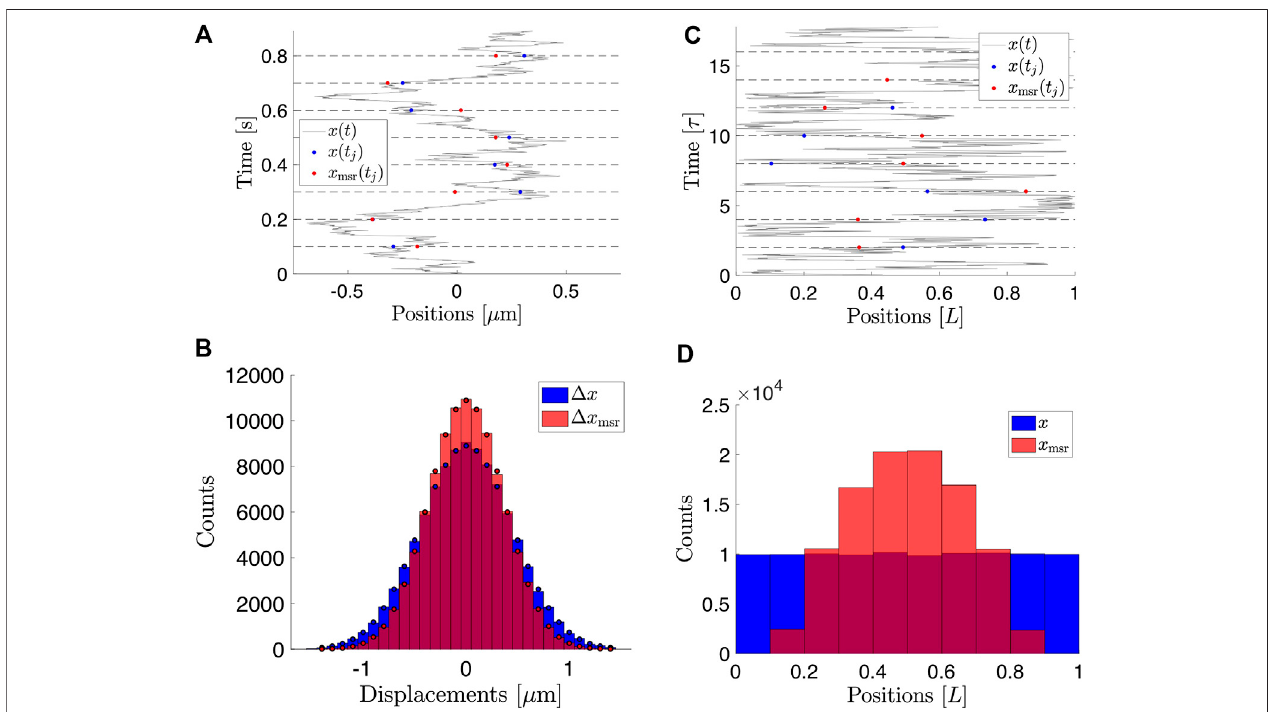
FIGURE 1 | Consequences of finite exposure time for the measured positions of a Brownian particle. (A) Simulated positions of a free Brownian particle with D (cid:2) 1 ( μ m ) 2 / s, Δ t (cid:2) Δ t open (cid:2) 0 . 1s.Inatime-lapse movieofit,inthe(arti fi cial)case ofinstantaneousrecording ofpositions,theparticle ’ spositions x j areitstrue positions measured at the end of each time interval, i.e., at times t j (cid:2) j Δ t (blue dots). In the (realistic) case of fi nite exposure time, the measured positions x msr ( t j ) are the time- averaged positions visited by the particle during the exposure time, as de fi ned in Eq. 1 (red dots). (B) Histograms of the displacements of the true, Δ x j (cid:2) x j − x j − 1 , and the measured, Δ x msr ( t j ) (cid:2) x msr ( t j ) − x msr ( t j − 1 ) , positions. Note that the variance of the measured displacements is smaller than the variance of the true displacements: motion blur effectively low-pass fi lters the true trajectory, which suppresses rapid displacements, so large displacements are less likely to occur within a time-lapseintheblurredtrajectory. (C) Sameas (A) foraparticlediffusingina1Dboxat [ 0 , L ] with τ (cid:2) L 2 / ( 4 D ) and Δ t (cid:2) Δ t open (cid:2) 2 τ . (D) Histogramsofthepositions(not the displacements) obtained as in C . Note that while the true position visits all positions in the box with equal probability, the fi nite exposure time reduces the variance of the measured positions such that the con fi ning domain appears smaller than it is.